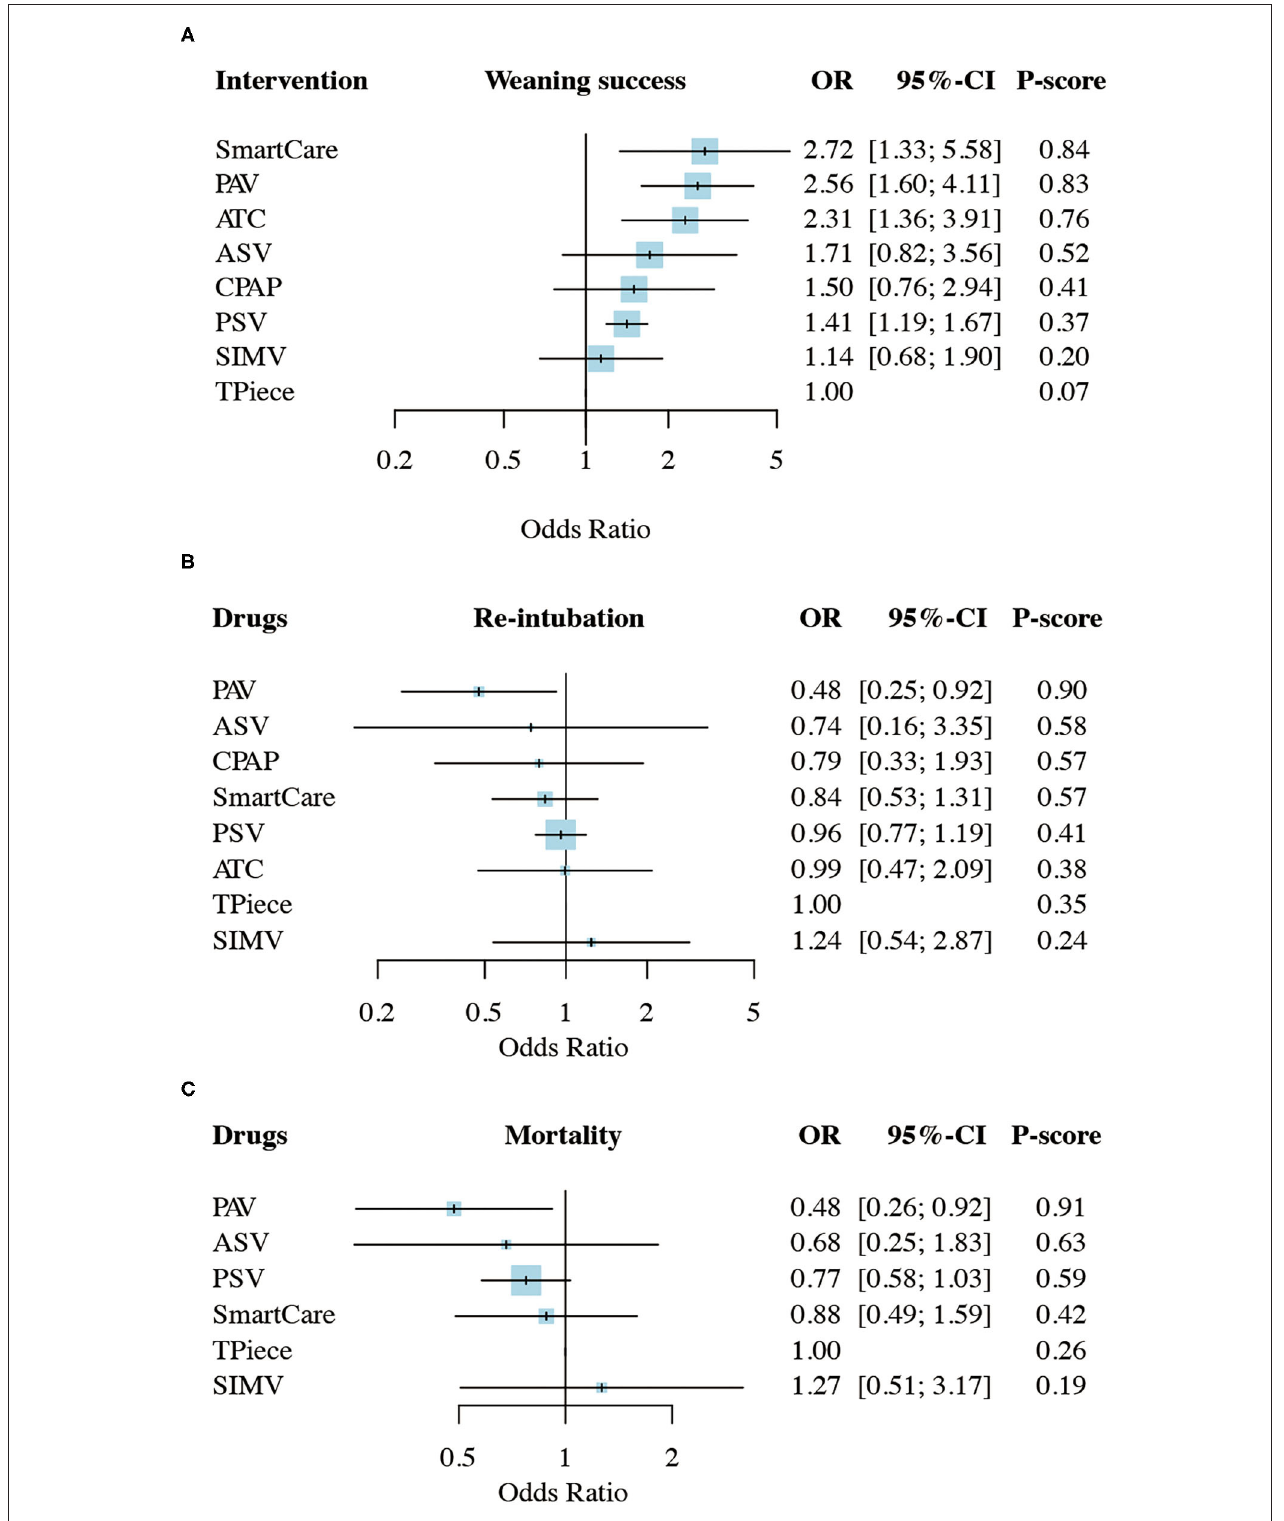
FIGURE 3 | Network meta-analysis results of (A) , weaning success (B) proportion requiring reintubation, and mortality (C) . ASV, Adaptive support ventilation; ATC, Automatic tube compensation; CPAP, Continuous positive airway pressure; PAV, Proportional assist ventilation; PSV, Pressure support ventilation; SIMV, Synchronized intermittent mandatory ventilation; OR, odds ratio; CI, confidence